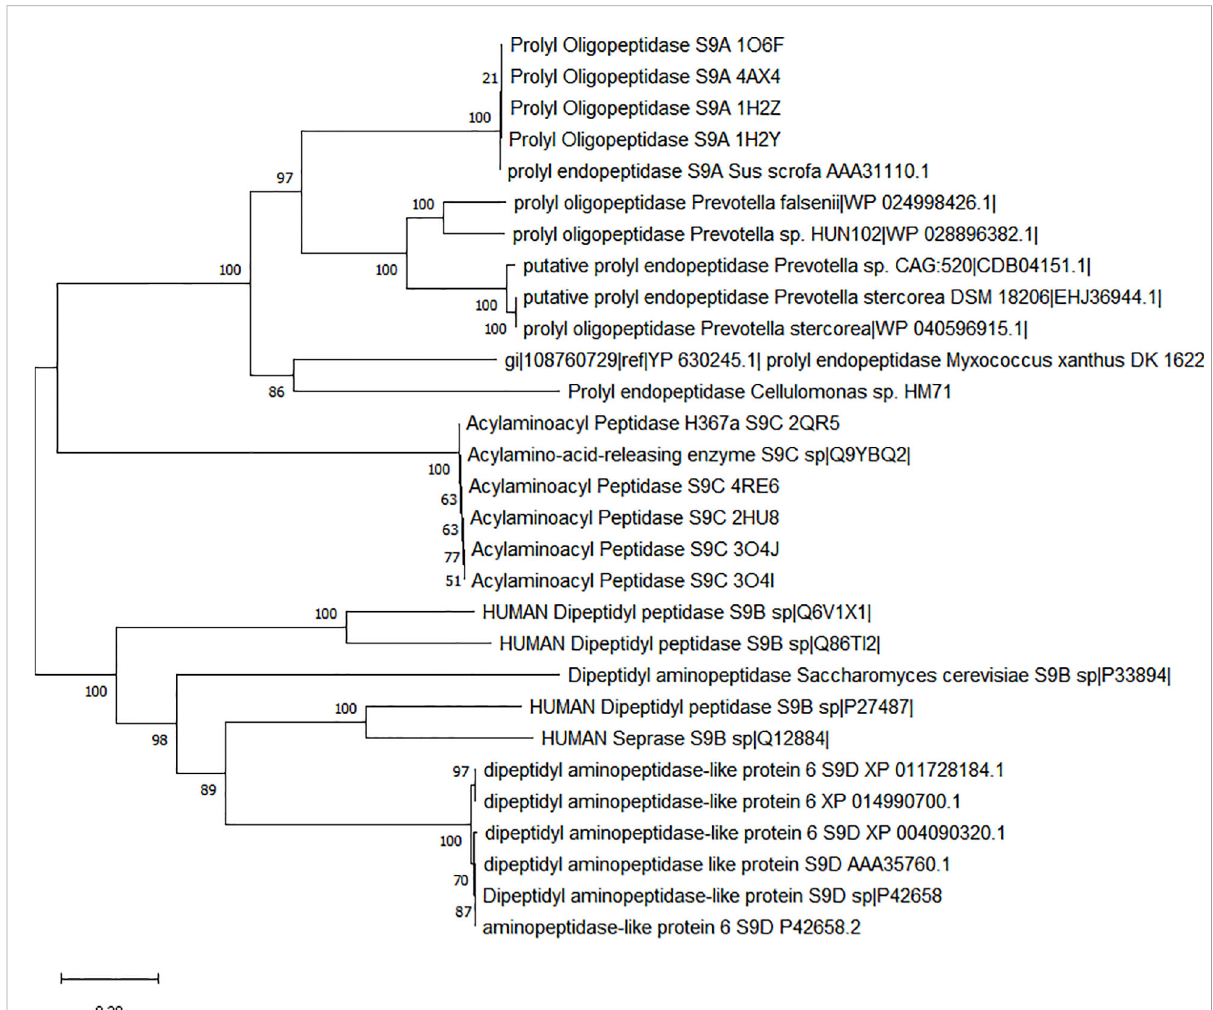
FIGURE 4 Phylogenetic characterization of Prolyl endopeptidase feature of Cellulomonas sp. HM71. Phylogenetic tree was constructed using the Neighbor-Joining (NJ) method with sequence of Cellulomonas sp. HM71 PEP and S9 Serine protease family members (S9A, S9B, S9C, and S9D). Numbers at the node represent bootstrap values. The bar at the bottom indicates the genetic evolutionary trajectory regarding genomic changes. The units of branch length are nucleotide substitutions per